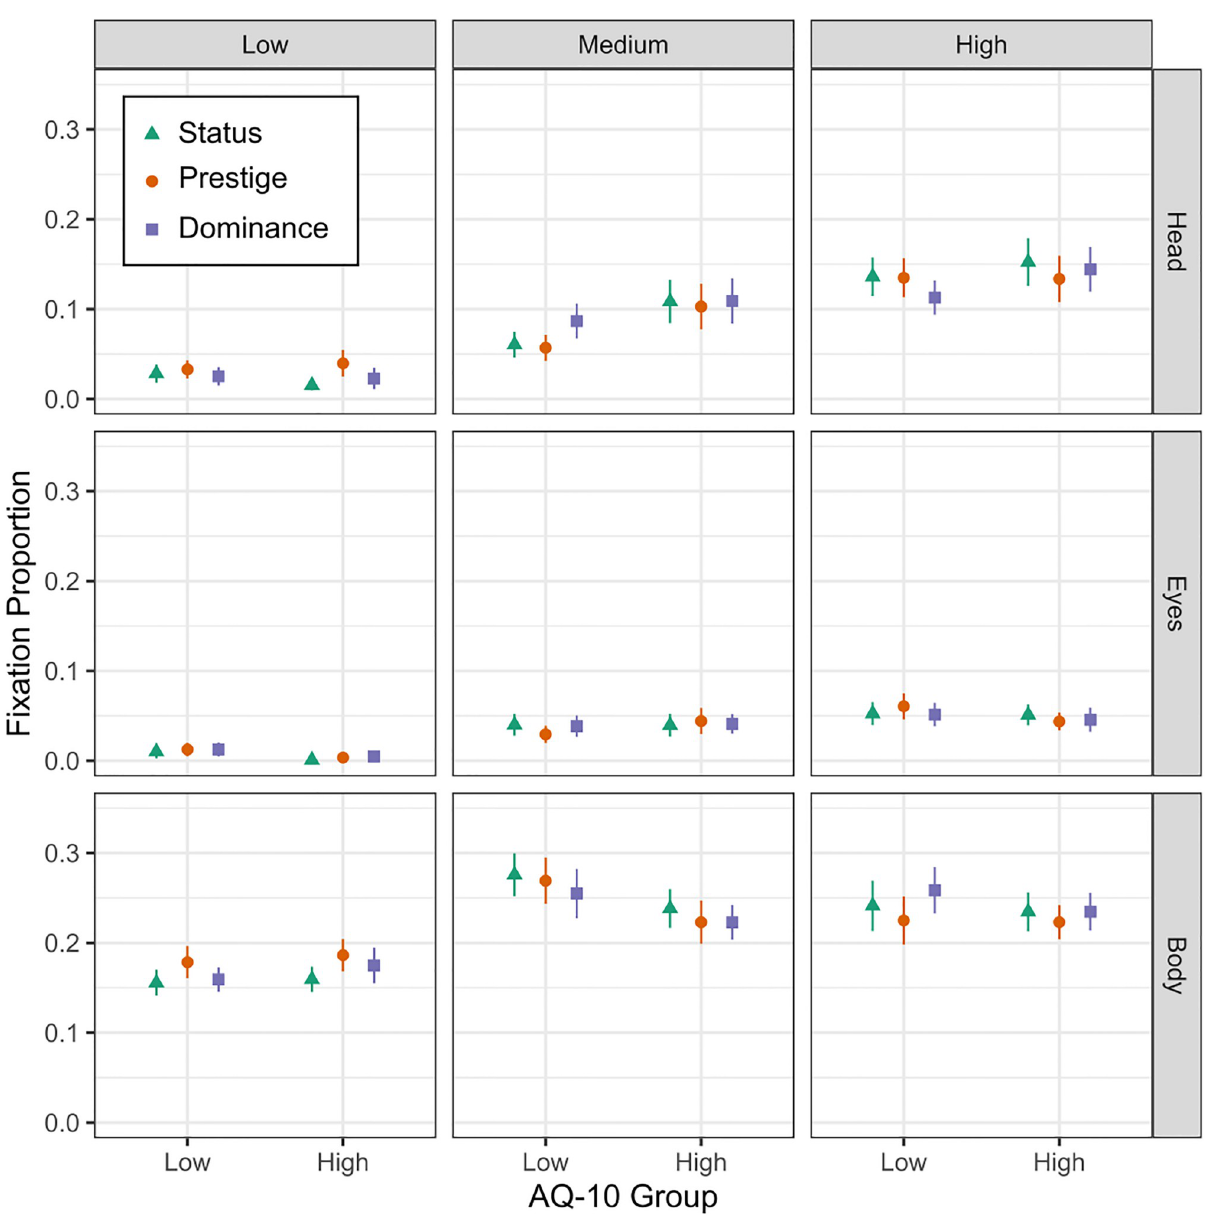
Fig 2. Proportions of fixations to body, head, and eyes. Note . Proportions of fixations to the areas of interest (AOIs) for Status (green triangles), Prestige (orange circles), and Dominance (purple squares) by AQ-10 group.